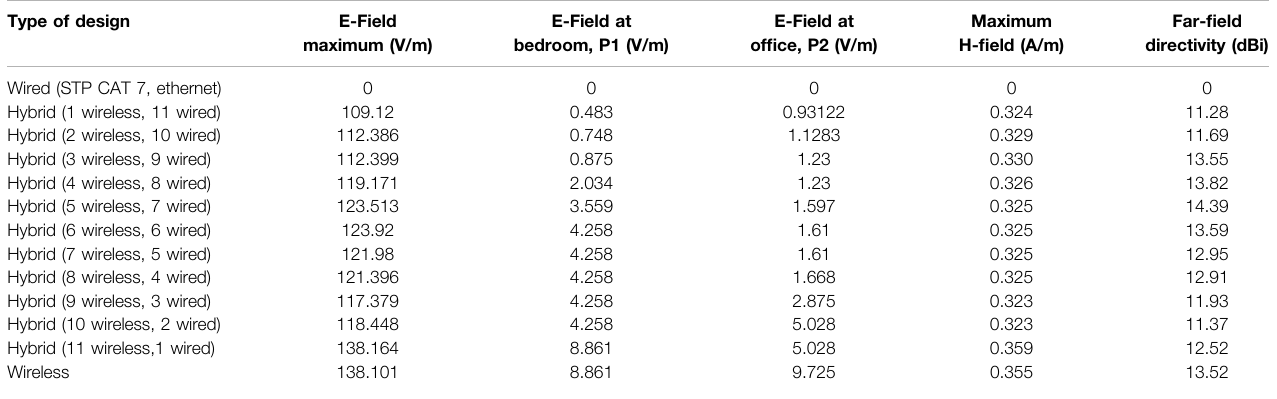
TABLE 2 | Summary results of E- fi eld, H- fi eld and far- fi eld directivity. Type of